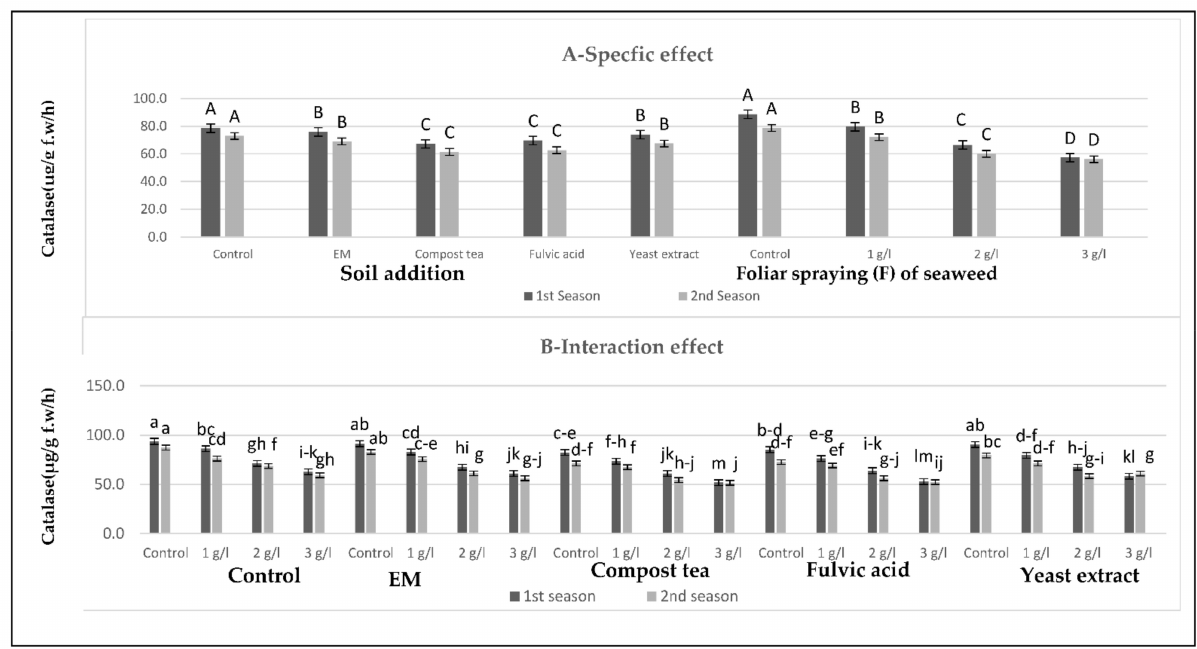
Figure 5. ( A , B ) Effects of the soil addition of EM, compost tea, fulvic acid, yeast extract, and foliar spray with seaweed extract on the catalase ( µ g/g f.w/h) of sweet pepper plants during the 2019/2020 and 2020/2021 seasons. Specific effects are indicated with uppercase letters and the interactions are indicated with lowercase letters, unless otherwise mentioned, according to Tukey’s multiple range test (TMRT) at p ≤ 0.05.